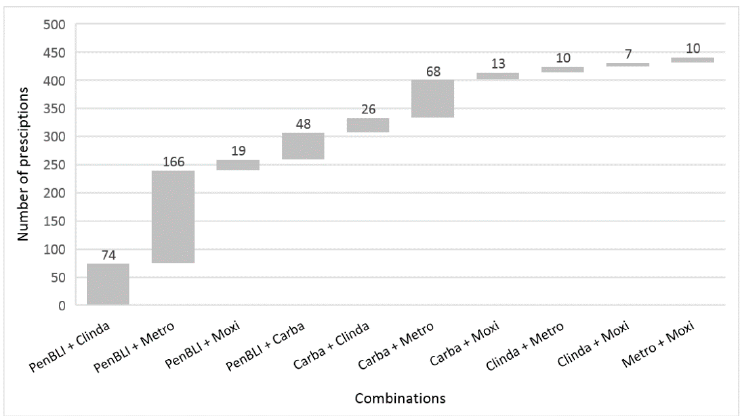
Figure 1. Number of redundant anaerobic antimicrobial prescriptions by the combination of anaerobic antimicrobial agents. Data from 218 hospitals that participated in the point prevalence survey 2016. Abbreviations: Carba—carbapenem; Clinda—clindamycin; Metro—metronidazole;